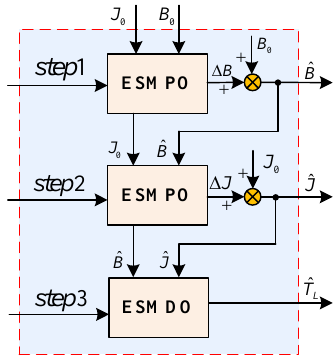
Figure 4. Procedure diagram of mechanical parameter estimation.